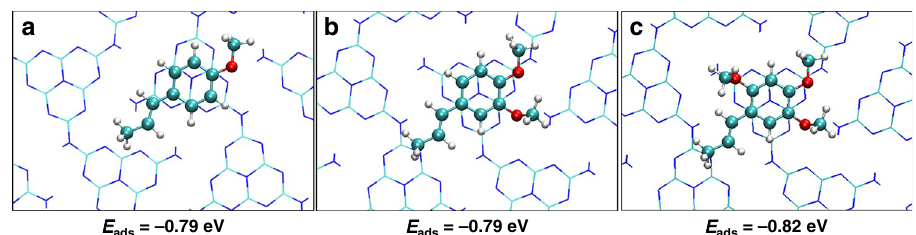
Fig. 2 The DFT calculation of absorption model. Optimized structures and adsorption energies of a anethole. b Methyl isoeugenol. c α -asarone on the surface of